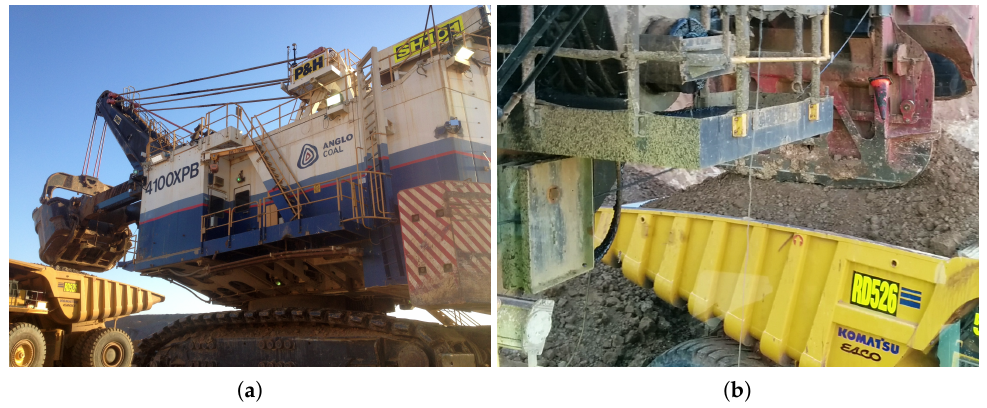
Figure 15. ( a ) Shows a rope shovel loading a haul truck with material during the excavation cycle. ( b ) Displays the truck’s tray being occluded with material.This creates a challenging environment when using the truck’s tray as the known geometry for point cloud